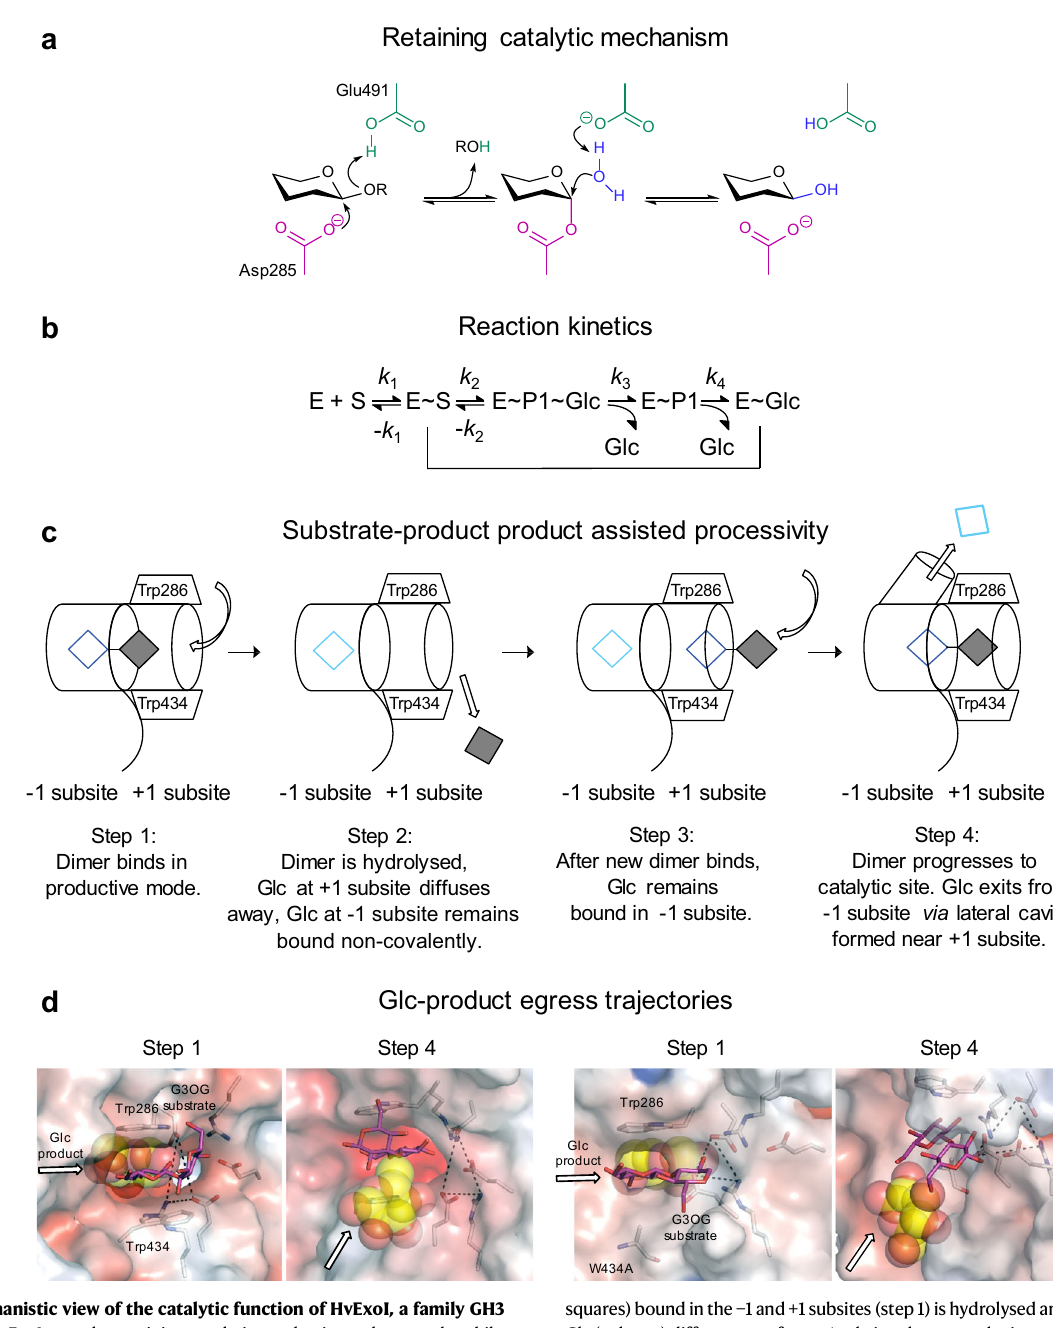
squares)boundinthe − 1and+1subsites(step1)ishydrolysedandthereducingend Glc(aglycon)diffusesawayfrom+1subsite,thenon-reducingendGlc(cyansquare) remains non-covalently trapped. After a new dimer binds (step 3) and advances to the catalytic site, Glc modi fi es its binding patterns and egresses (large arrow) via a transient lateral cavity (cylinder in dotted lines) formed near the Trp clamp (step 4) 22 . Curved arrows indicate dimer entries into the catalytic site. d Glc dis- placement paths inWT(leftpanels),and the W434Amutant (rightpanels) with Glc and the G3OG dimer, calculated through cMD and GPathFinder. Large arrows indicateGlcpositionsattheinitial(step1)andafterthe fi nal(step4 – followingGlc departure from − 1 subsites) stages of catalysis (this